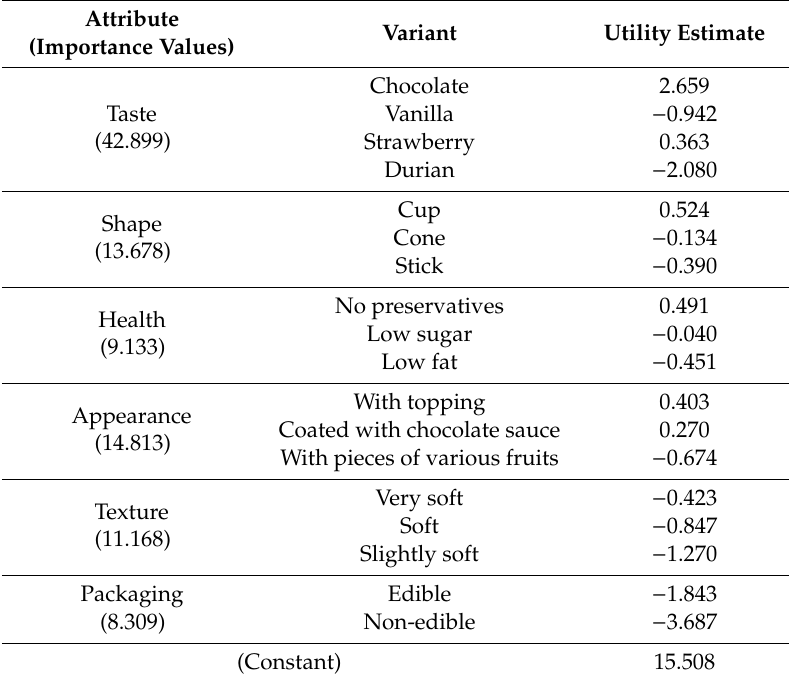
Table 7. Utility estimate of each